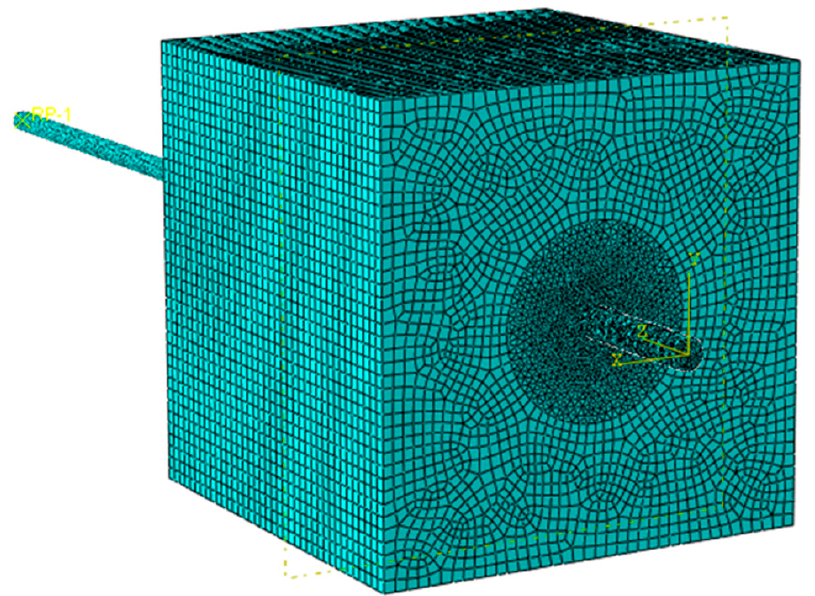
Figure 8. Assembled FE model of CFRP bar and SSSC cube. Table 5. Material properties of SSSC cube and CFRP